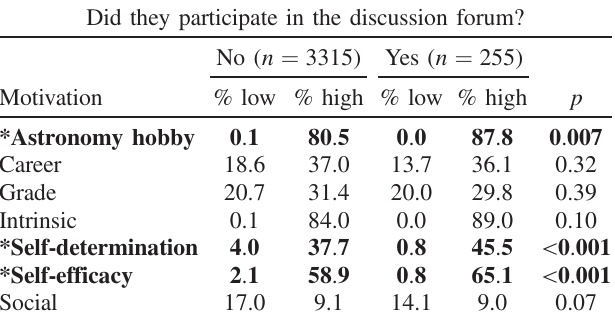
TABLE VIII. Percentages of learners in the low and high tiers of each motivational category for those who did not engage in the peer grading and for those who did. Statistically significant results at the p ¼ 0 . 05 level using the Kolmogorov-Smirnov two sample test are denoted with asterisks and in bold type. Did they engage in the peer grading? No ( n ¼ 2729 ) Yes ( n ¼ 841